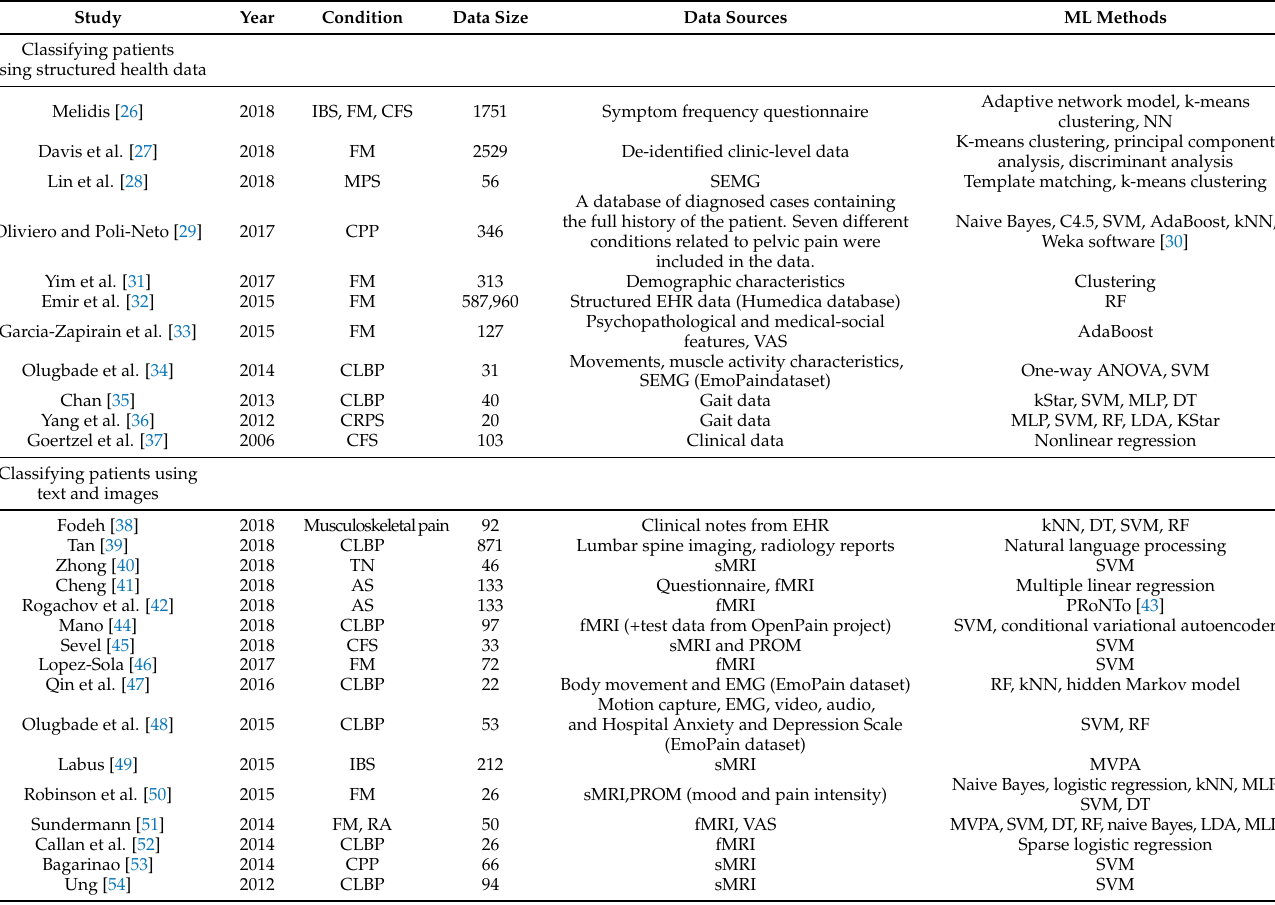
Table 1. Decisions: Classifying using health data, classifying using text and images, genomics approaches and biomarker identification, treatment, self-management, and measuring pain